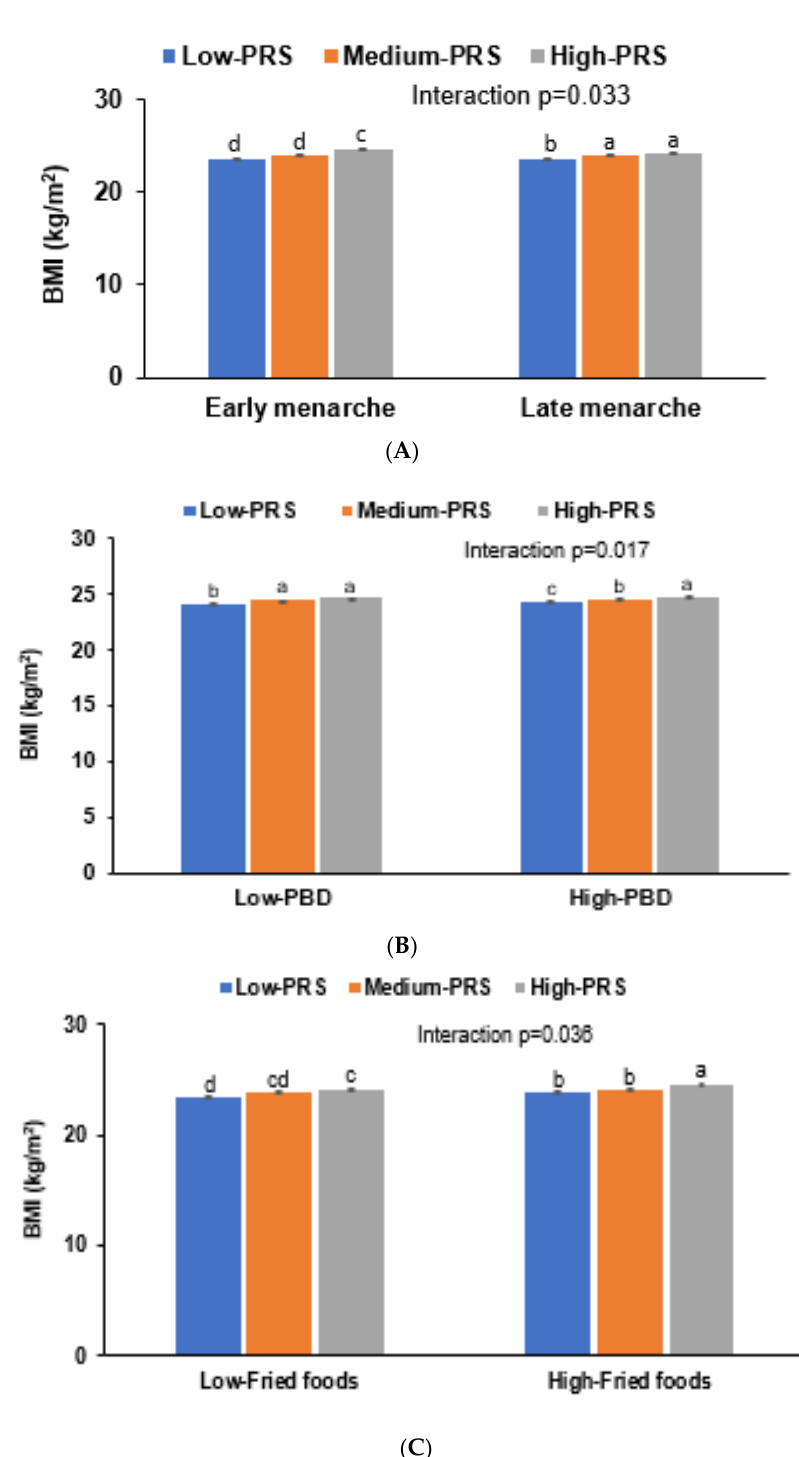
Figure 3. Body mass index (BMI) of participants with low, medium, or high polygenetic risk scores (PRS) as determined using the 5-SNP model. ( A ) Adjusted means and standard errors of participants of BMI categorized by menarche age (a cutoff value: 15 years). ( B ) Adjusted means and standard errors of participants of BMI categorized by a plant-based diet (PBD; a cutoff value: 70th percentiles). ( C ) Adjusted means and standard errors of participants of BMI categorized by fried-food intake (a cutoff value: once a week). Covariates included age, gender, education, income, energy intake (percentage of estimated energy requirement), occupation, residence area, regular exercise, alcohol intake, and smoking status. a,b,c,d Different letters on the bar indicated significant differences among the groups in Tukey’s test at p < 0.05. Table 6. Adjusted odds ratios for obesity risk by polygenetic risk scores (PRS) of the best model for gene − gene interaction after covariate adjustments according to lifestyles patterns.